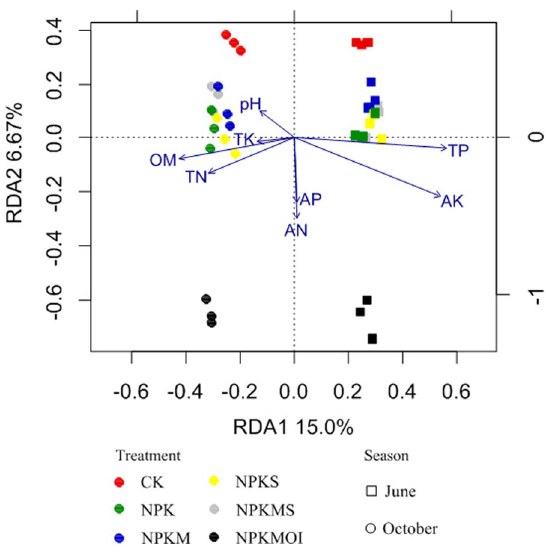
Figure 2. Redundancy analysis of soil bacterial communities and soil characteristics for individual samples. Samples from different fertilizer regimes both in June (square) and October (circle) were marked by different colors. Symbols of fertilizer regimes were as described in Table 1.